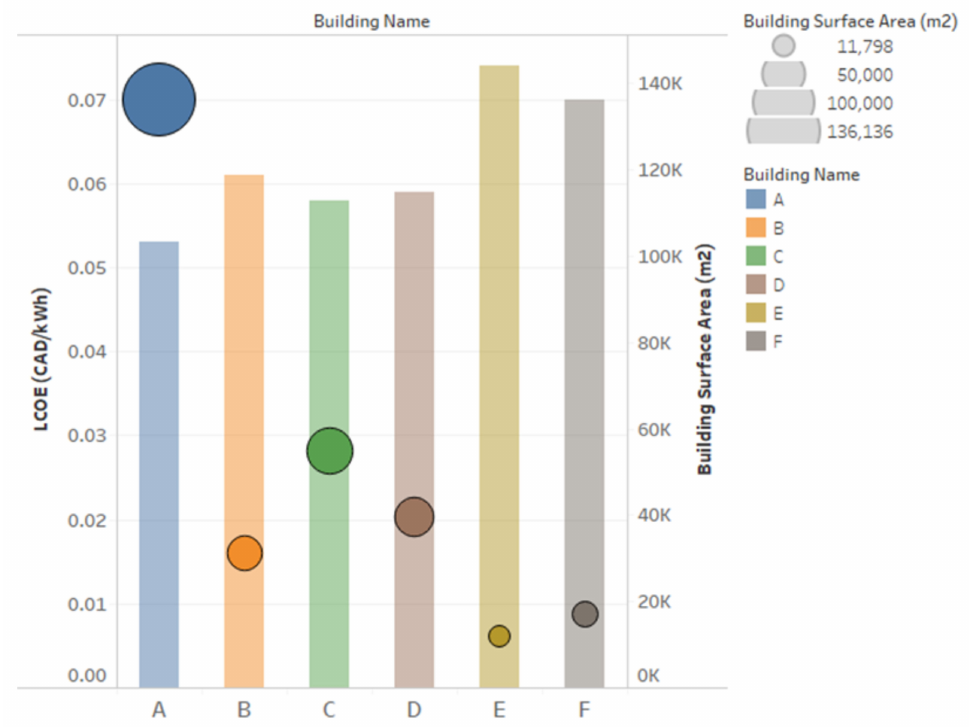
Figure 9. Surface area and Levelized Cost of Energy (LCOE) for each